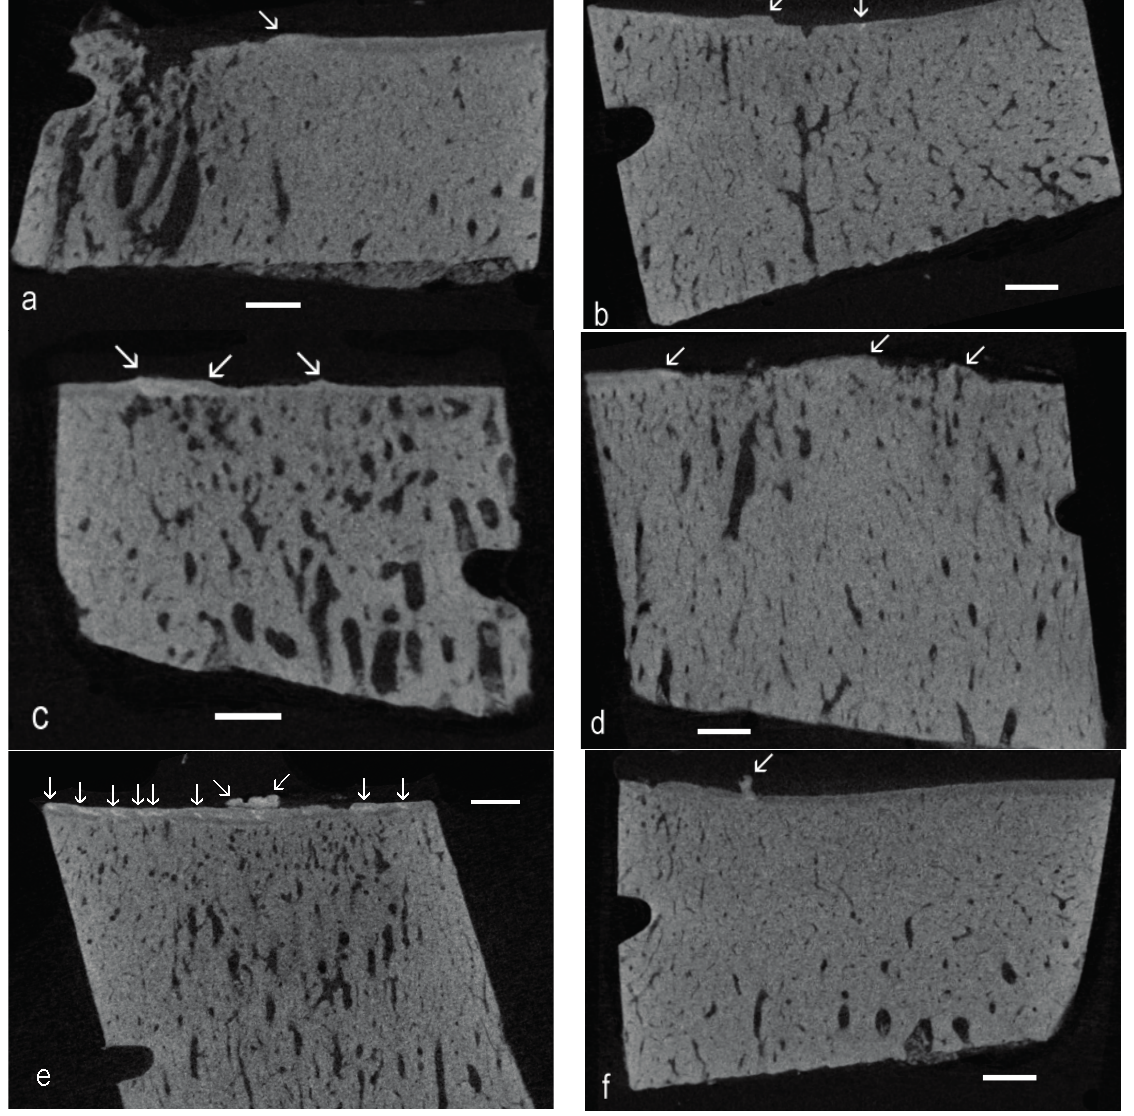
Figure 2. Unprocessed single XY plane images from Z stacks with localized patches (oblique arrows) with higher density proud of the level of the mineralizing front (MF) of the ACC. ( a ) Advanced OA, seven-year-old; ( b ) Advanced OA, four-year-old; ( c ) Early OA, two-year-old; ( d ) Advanced OA, seven-year-old; ( e ) Early OA, six-year-old; and ( f ) Advanced OA,